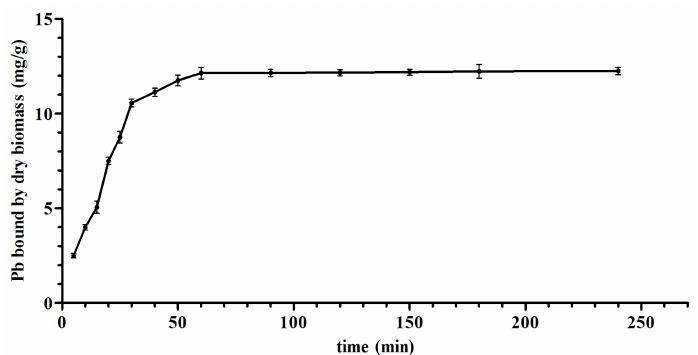
Figure 3. Pb binding of L. bulgaricus KLDS1.0207 at different time points. Values are mean ± standard deviation (SD) of three determinations.